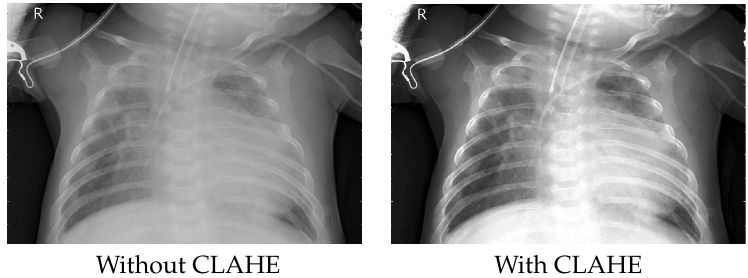
Figure 3. Contrast enhancement on the X-ray